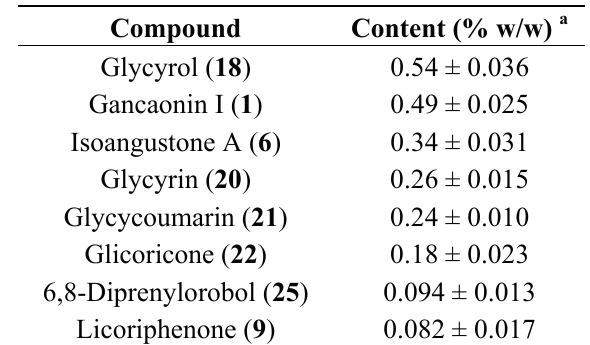
Table 3. Contents of major licorice phenolics in G. uralensis (Tohoku licorice) EtOAc